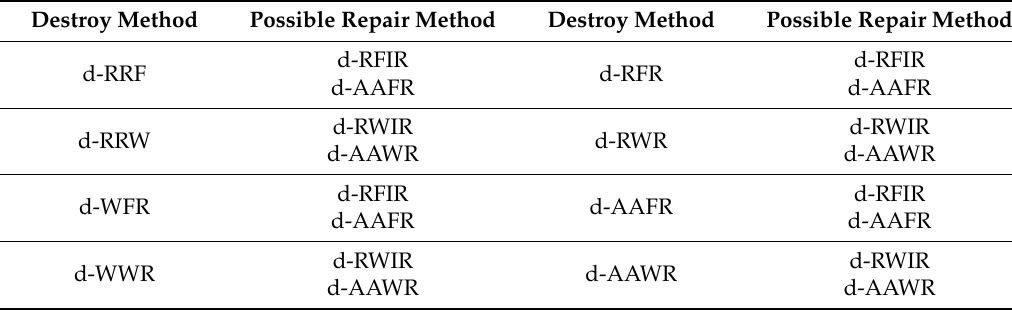
Table 5. The possible repair method which is usable for each destroy